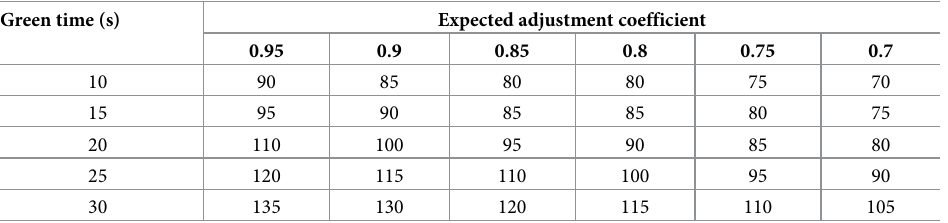
Table 11. Recommended length of displaced left-turn lanes